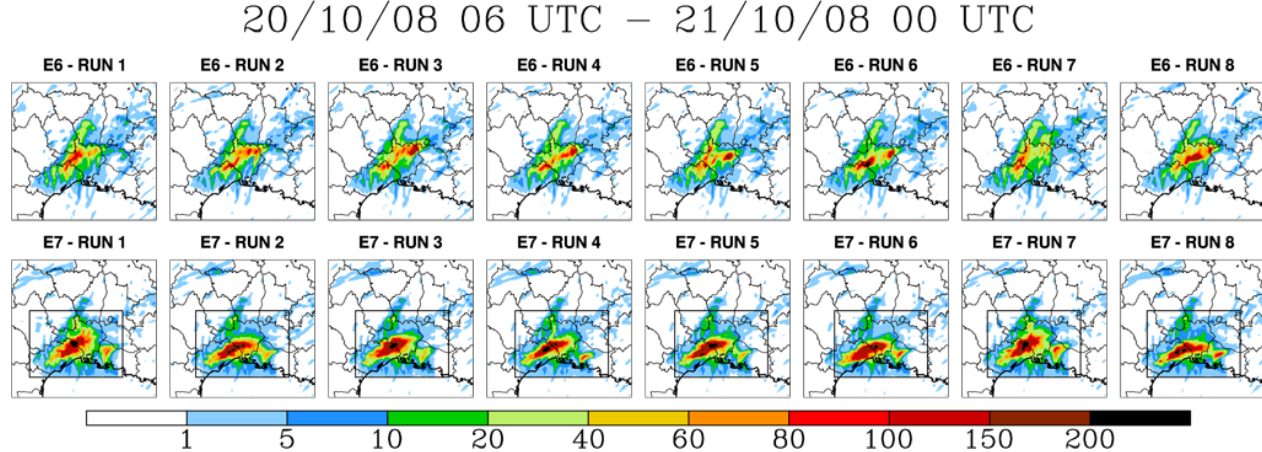
Fig. 14. 18h accumulated precipitation computed for the Gard-H´erault case for the E6 (top) and E7 (bottom) ensembles. The rectangle indicates the location of the inner computational domain used in the E7 ensemble.